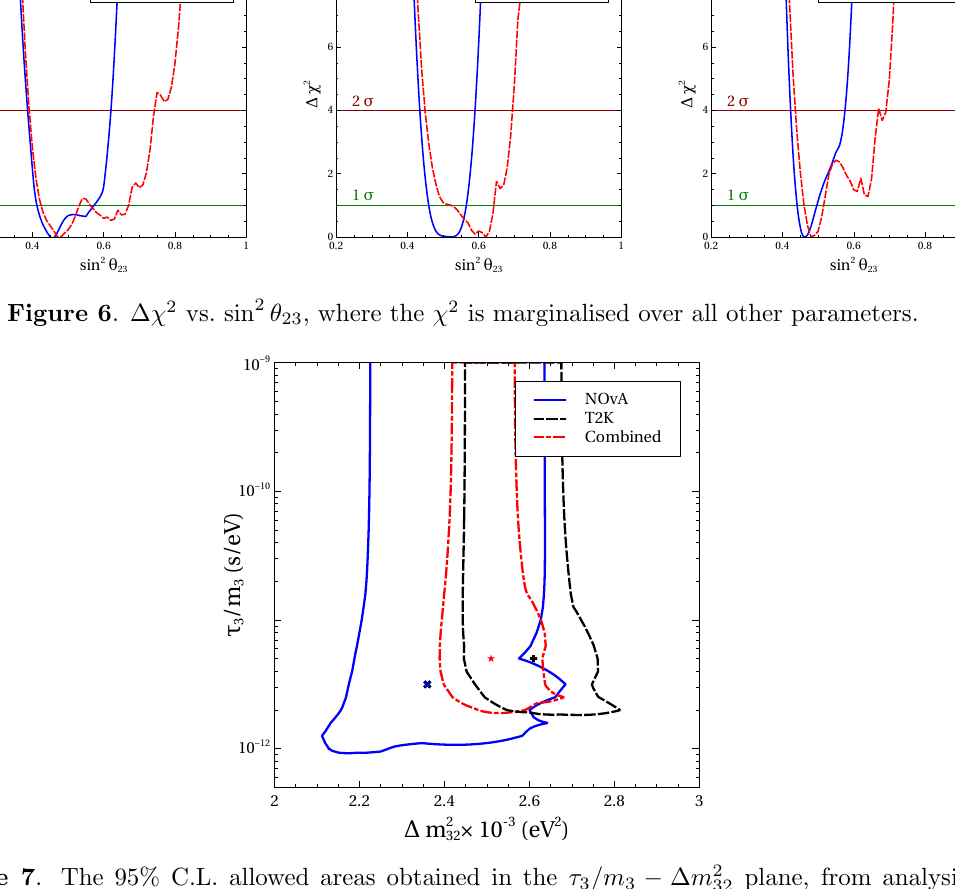
plane, from analysis of 32